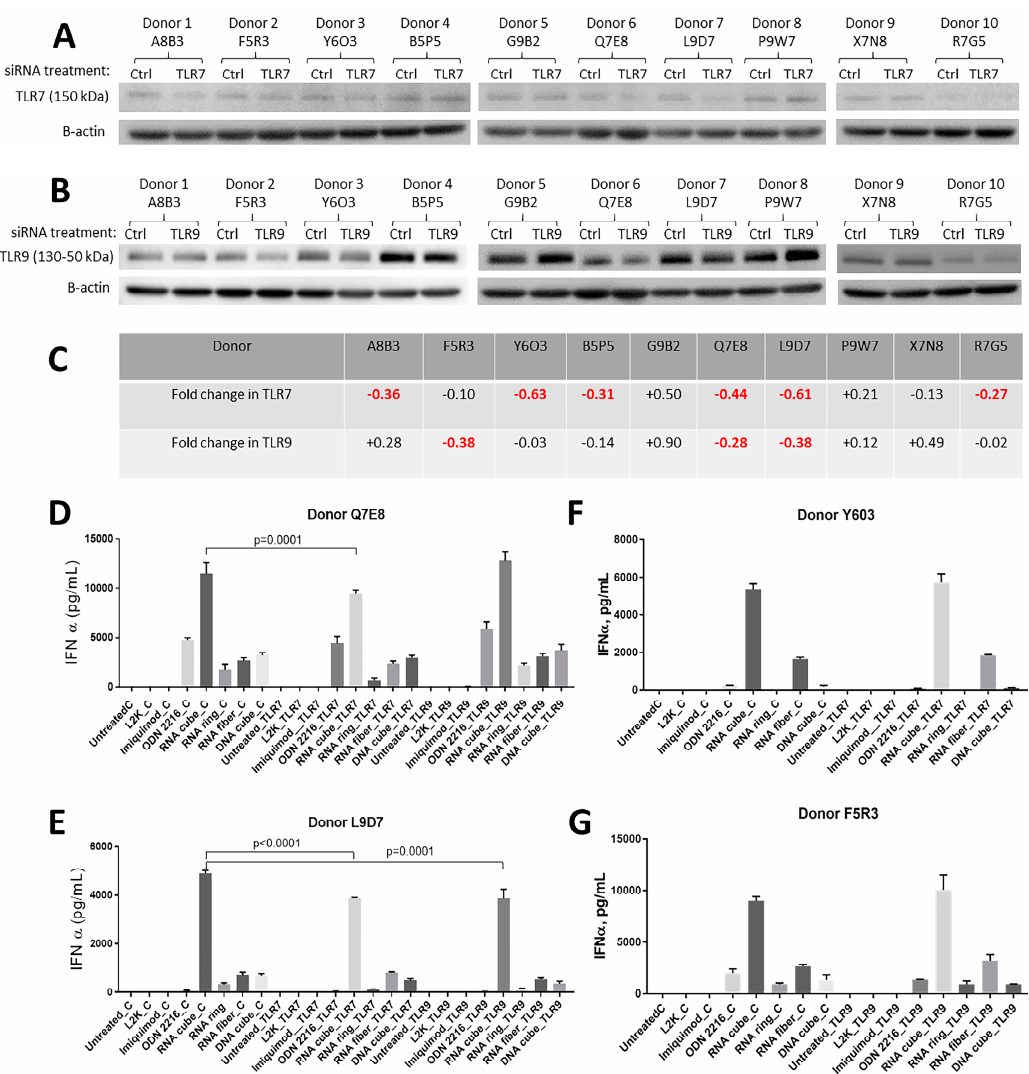
Figure 3. Effects of the inhibition of TLR7 and TLR9 expression on the IFN production by PBMCs treated with NANPs. Freshly isolated PBMCs were either untreated or treated with Accel control siRNA or siRNA specific to either TLR7 or TLR9. NANPs were delivered to cells 36 h after the exposure to siRNA, and the incubation continued for 24 h. At the end of the incubation time, supernatants were collected and analyzed for the presence of IFN α by ELISA, while cell lysates were analyzed for the expression of TLR7 and TLR9 by western blot. ( A ) Selection of donors whose cells responded to Accell SmartPool siRNA by downregulation of the TLR7 protein level. Beta-actin was used to control well loading. ( B ) Selection of donors whose cells responded to Accell siRNA by downregulation of the TLR9 protein level. Beta-actin was used to control well loading. ( C ) Densitometry analysis of western blots shown in A and B. Highlighted in red are the results of the individual donor cells demonstrating at least 25% reduction in TLR7 or TLR9 expression as compared to a respective control group exposed to the control siRNA. ( D , E ) Induction of IFN α by NANPs in PBMCs of donor Q7E8 and L9D7 treated with controls and TLR7 or TLR9 siRNA. ( F ) Induction of IFN α by NANPs in PBMCs of donor Y6O3 treated with controls or TLR7 siRNA. ( G ) Induction of IFN α by NANPs in PBMCs of donor F5R3 treated with controls or TLR9 siRNA. A statistically significant difference ( p < 0.05) is highlighted above bar graphs showing the respective p-value. ODN2216, an oligonucleotide, known to induce interferon response via TLR9 and imiquimod, known to stimulate TLR7, were used in our study as positive controls. L2K is lipofectamine carrier, which was used as a baseline control to normalize for potential carrier-mediated